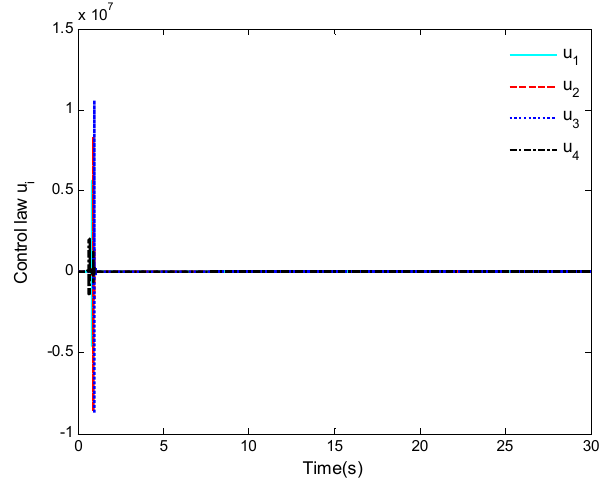
Figure 14. The curves of the control law u i